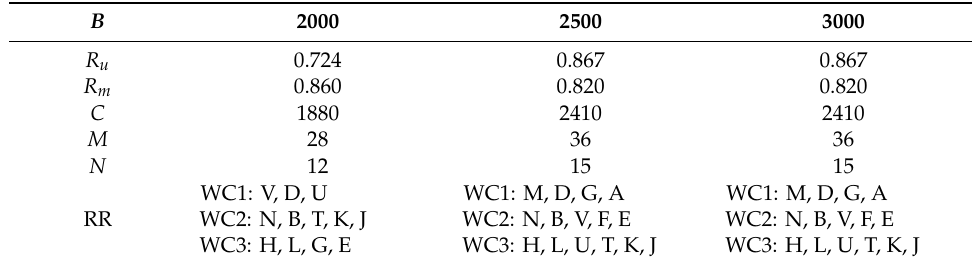
Table 9. Restoration results for di ff erent B